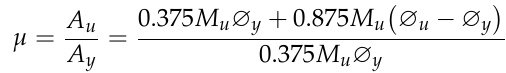
Figure 10. ( a ) Moment – curvature of beams and ( b ) ultimate moment – reinforcement ratio relation.